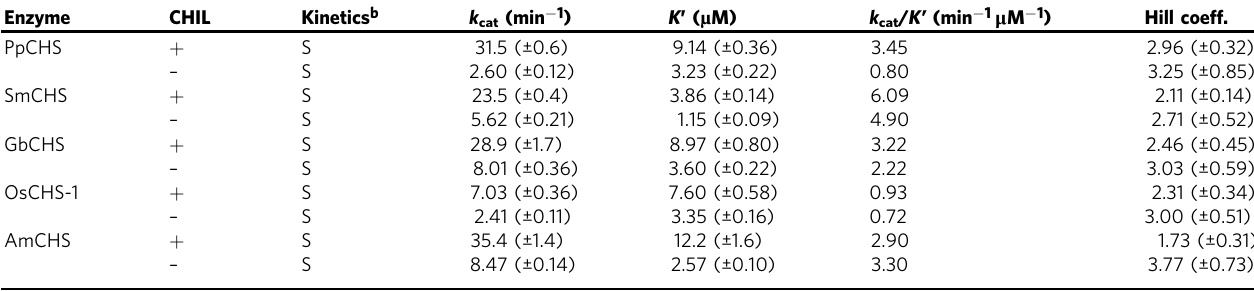
Table 3 Kinetic parameters for malonyl-CoA of THC production catalyzed by CHS of some land plants in the presence ( + ) and absence ( – ) of CHIL a .